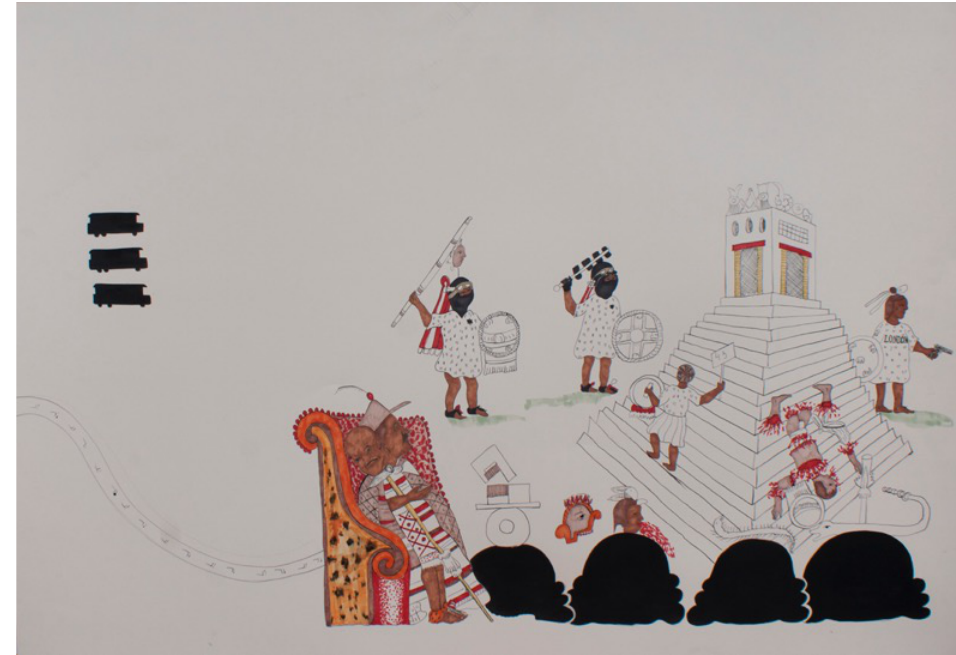
Gabriel Garcilazo, Dystopic Magical Codex: Codex 13 (The Journey through Mexico) , 2015. Charcoal and ink on paper. 70 x 100 cm. Private collection. Image courtesy of the